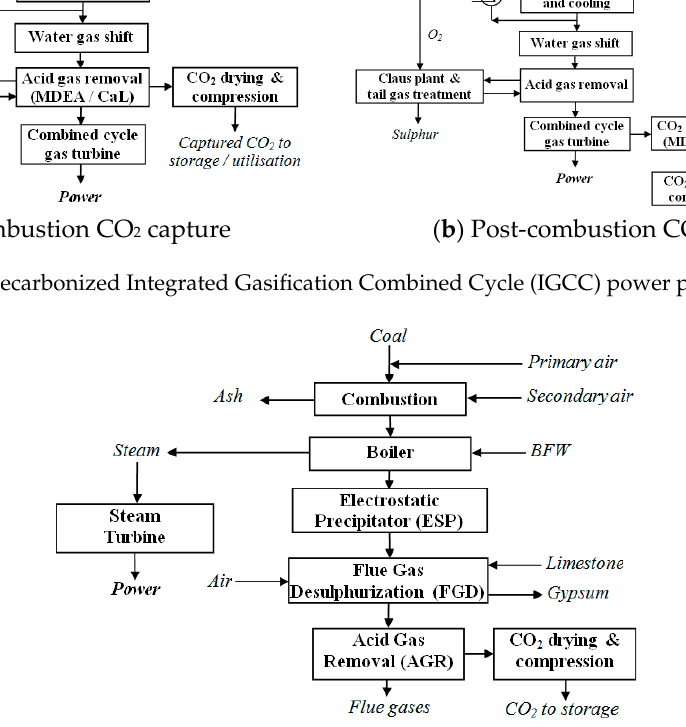
Figure 3. Decarbonized Integrated Gasification Combined Cycle (IGCC ) power plant options.